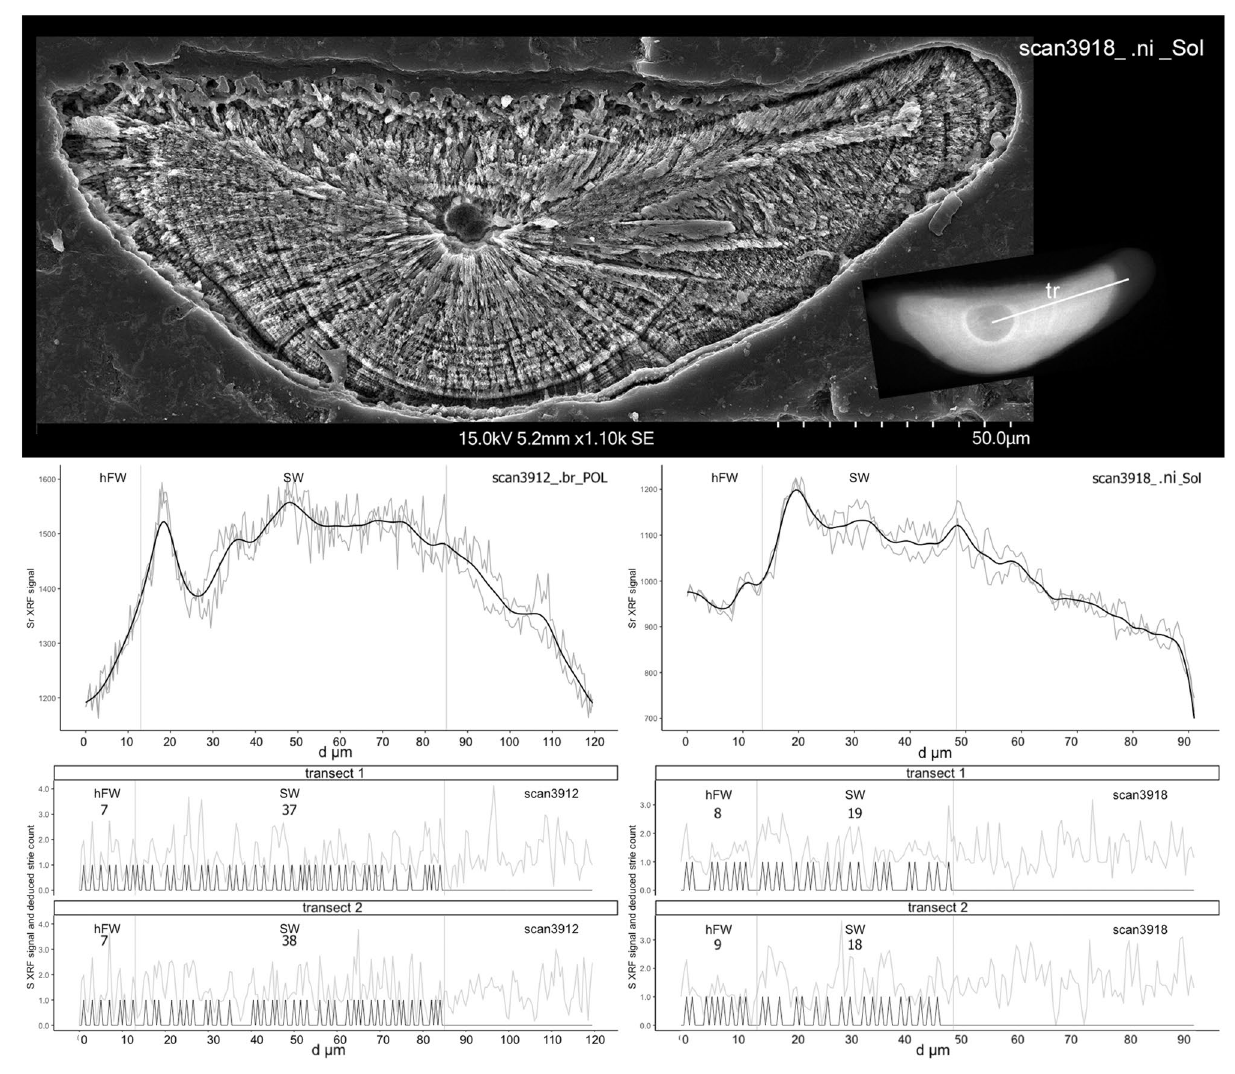
Figure 5. Interpolation of linear coordinates of strontium (Sr) and sulphur (S) signal allowed by XRF high spatial resolution mapping to uncover the growth increment checks in the otolith. On top of the figure, picture shows SEM image of otolith after the mild etching. Transects were performed on XRF scans for Sr and S starting from the nucleus to the edge (see inset). Middle graphs present boundaries between fresh- and seawater (hFW and SW respectively) which were deduced from the shifts after smoothing (black line) of Sr signal. Bottom graphs show S traces on the transects, with the environment transition limits deduced from Sr level major changes and the incremental growth exposed by deciphering the S sawtooth shaped trace